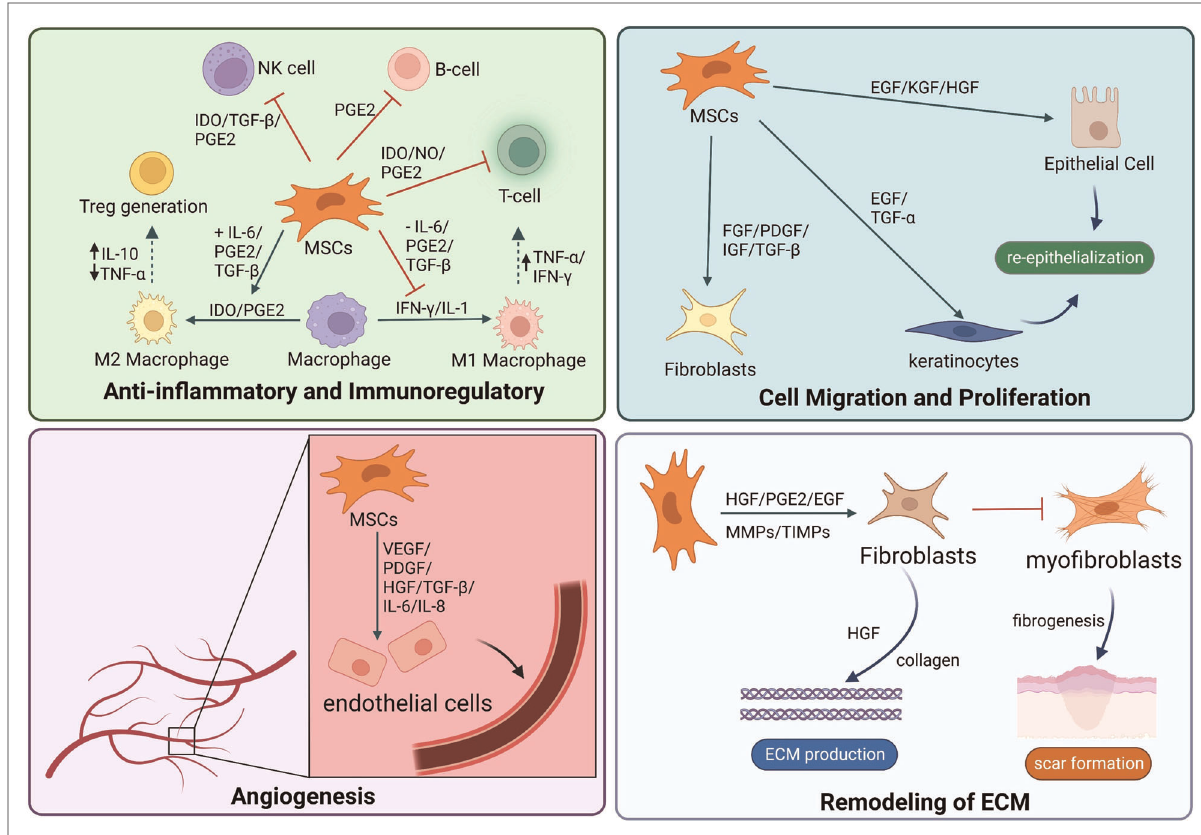
FIGURE 1 MSCs promote skin tissue regeneration through anti-in fl ammatory and immunoregulatory, cell migration and proliferation, angiogenesis, and ECM remodeling. MSCs, mesenchymal stromal cells; ECM, extracellular